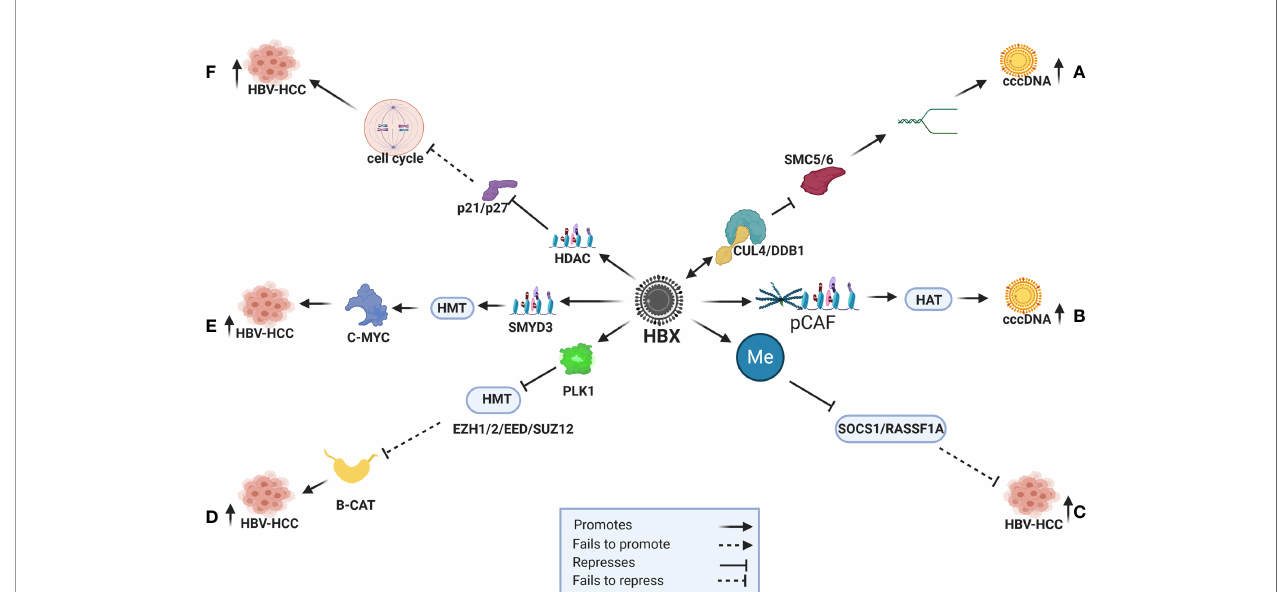
FIGURE 1 | HBx induced epigenetic expression in HBV-HCC. (A) HBx recruits the CUL4/DDB1 ubiquitination complex to repress SMC5/6 and promote DNA relaxation and cccDNA transcription. (B) HBx recruits CBP/p300 (pCAF) to transactivate HAT (H3K9ac) to promote cccDNA expression. (C) HBx promotes DNMT to repress SOCS1/RASSF1A tumor suppressors that fail to modulate HCC pathogenesis. (D) HBx promotes PLK1 to block HMTs (EZH1/2/EED/SUZ12) that then fail to modulate B-CATENIN induced hepatocarcinogenesis. (E) HBx initiates HMTs (SMYD3) to promote C-MYC induced HCC. (F) HBx promotes HDAC to silence cell cycle controls like p21/p26 and promote